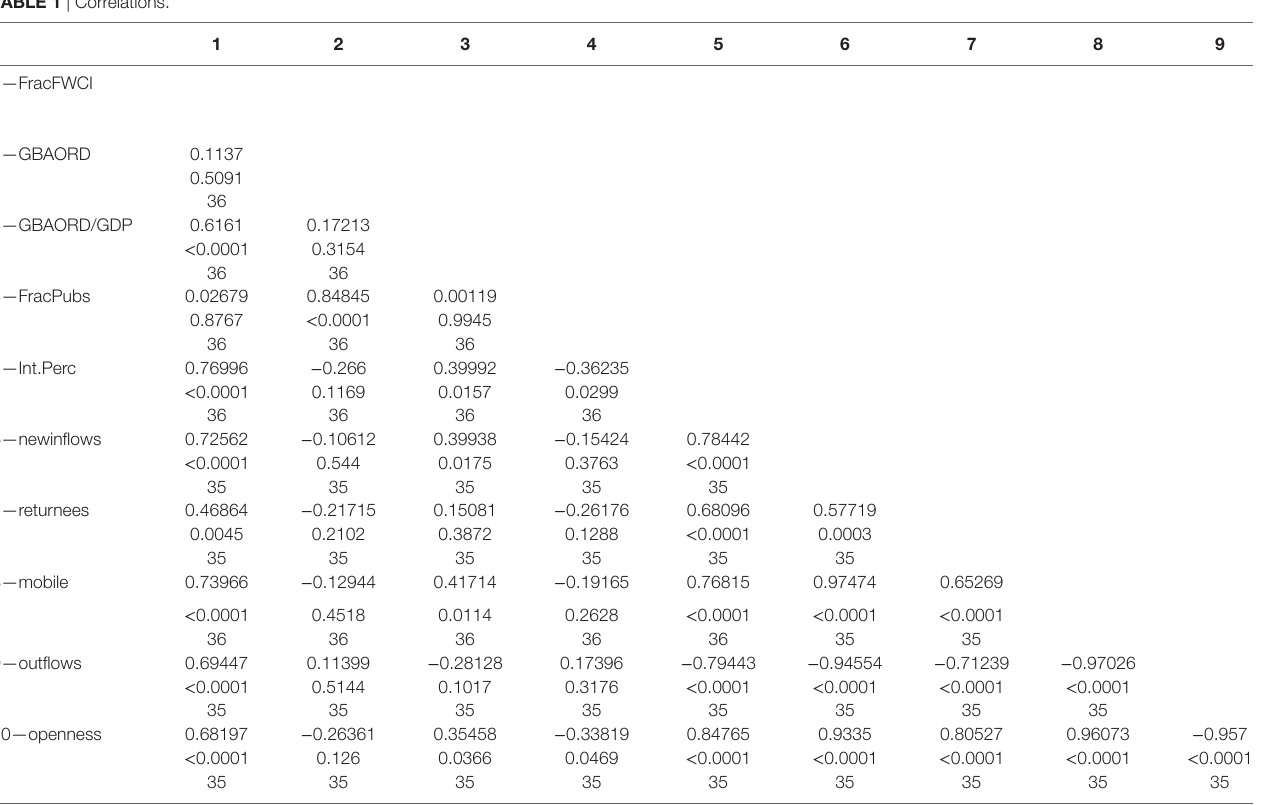
Top row, coefficient; middle row, p-value; bottom row, sample